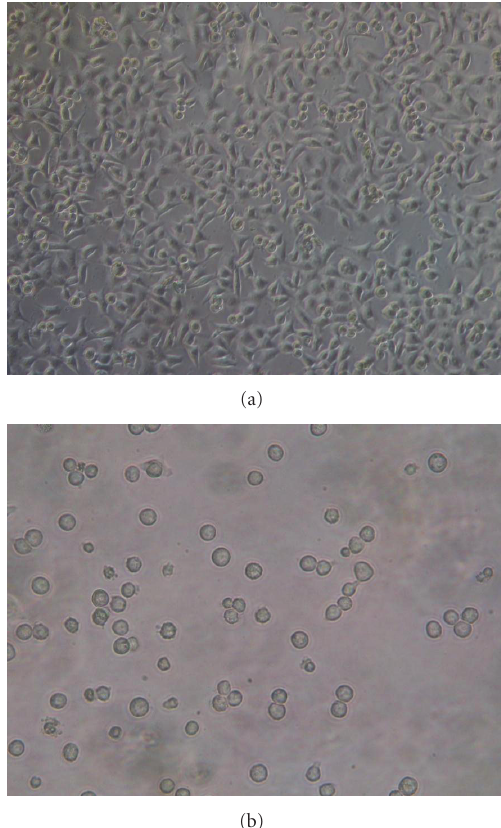
Figure 1: Digital photo before (a) and after (b) being induced by 89 Sr (3330kBq/mL) (microscopically).